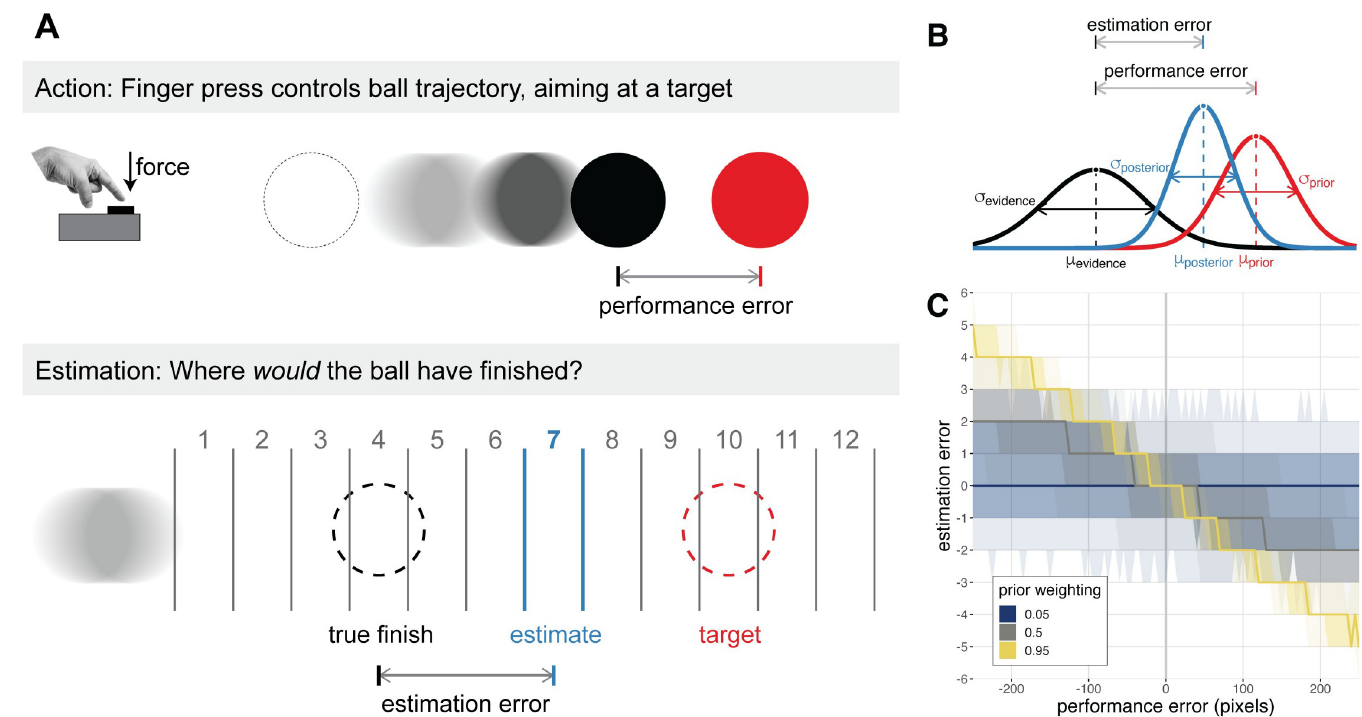
Fig 1. Visuomotor task and Bayesian modelling approach. A) Participants performed a sustained finger press to trigger a ballistic ball trajectory, aiming it at a target. For the majority of trials, an animation of the ball trajectory was shown, and participants sought to minimise their performance error–the distance of the final ball position from the target (top row). For the remaining trials, the ball trajectory was hidden and participants were asked to estimate where the ball would have finished. Participants were given 12 evenly spaced response options, one of which was pseudorandomly selected to be centred on the true final ball position (i.e., the veridical response option). The difference between the chosen and veridical response option constitutes the estimation error (bottom row). The pointing finger image was adapted from the Wikimedia Commons, available at https://commons.wikimedia.org/wiki/File:Index_finger_down.JPG under a CC BY-SA 3.0 license (https://creativecommons. org/licenses/by-sa/3.0/). B) Estimates of performance were modelled as a precision-weighted combination of a prior, centred on the target, and trial-wise sensory evidence, centred on the true final ball position. The relationship between estimation errors and performance errors is indicative of prior weighting–the precision of the prior relative to sensory evidence. C) Simulation demonstrating that prior weighting corresponds to the slope of the linear relationship between performance error and estimation error. For a given performance error and setting of prior weighting, the bold line represents the median predicted estimation error, and the increasingly transparent shaded areas represent the 25% and 50% quantile intervals of the predicted estimation error,